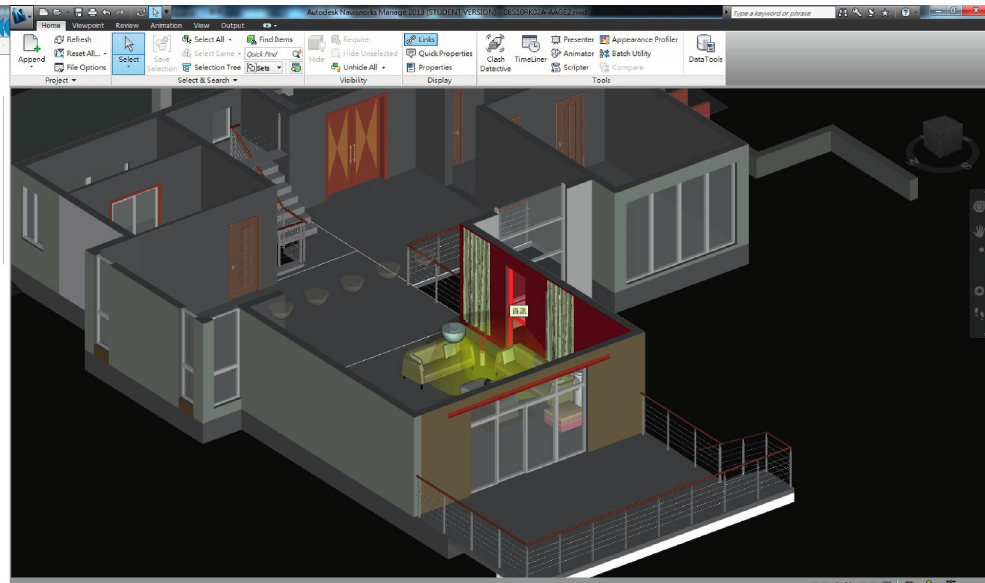
Figure 9: The illustration of the facility’s location from BIM.